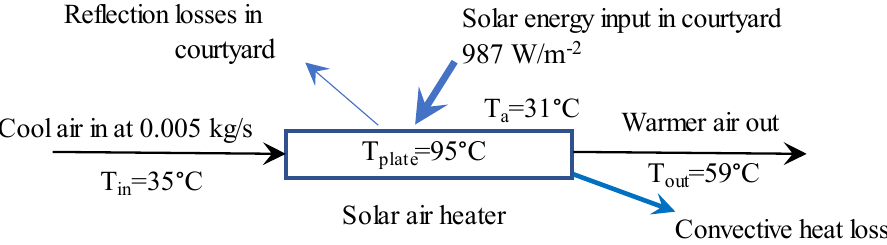
Figure 6. Schematic diagram of mass and energy flows in the experiments for the heat loss measure- ments in the courtyard.